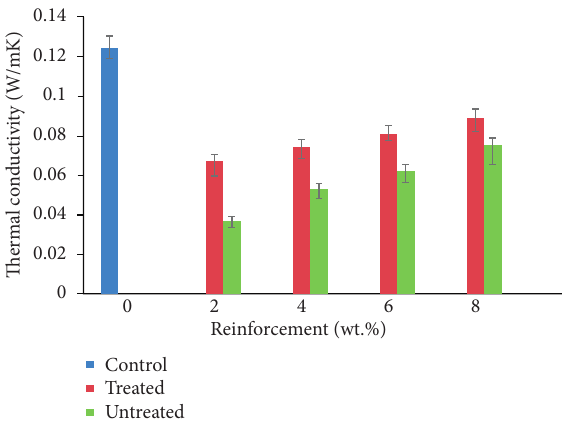
Figure 10: Variation in thermal conductivity of coir fibre and yam peel particulate polyethylene